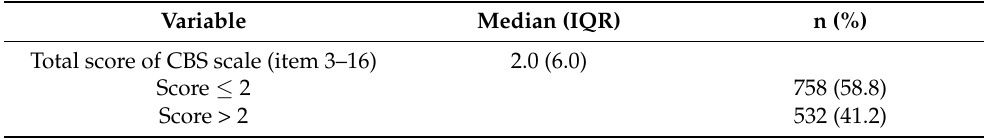
Table 4. Frequency of cyberbullying victimization (n = 1290).